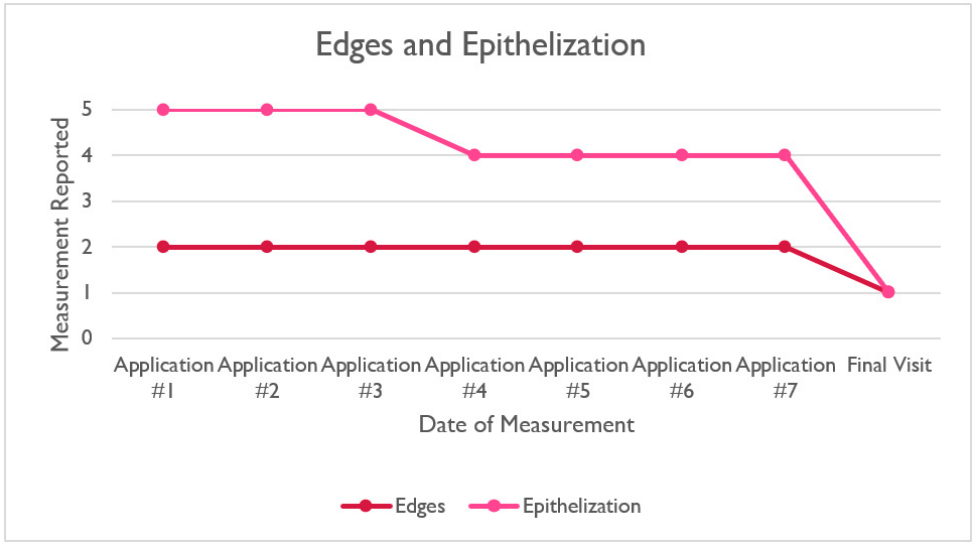
Figure 3. Progression of edges and epithelization in DFU over 49 days. Reference Appendix B for the key correlated to each value. Table 2. Progression of size, depth, edges, necrotic tissue amount, and epithelization in DFU over 49